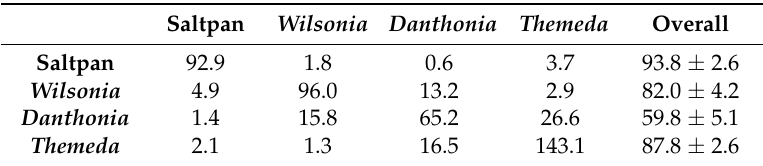
Table A5. Mean confusion matrix for full-HSR four-class classification results. Confusion values are given as a count value, and overall accuracies as a percentage with standard deviation.